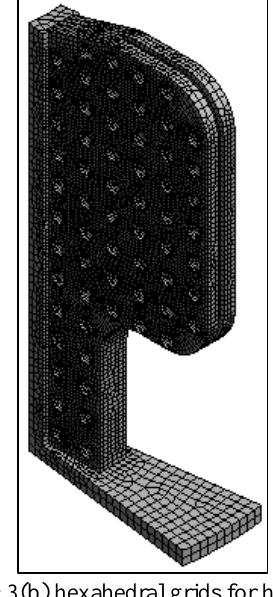
Figure: 3(b) hexahedral grids for heat sink.